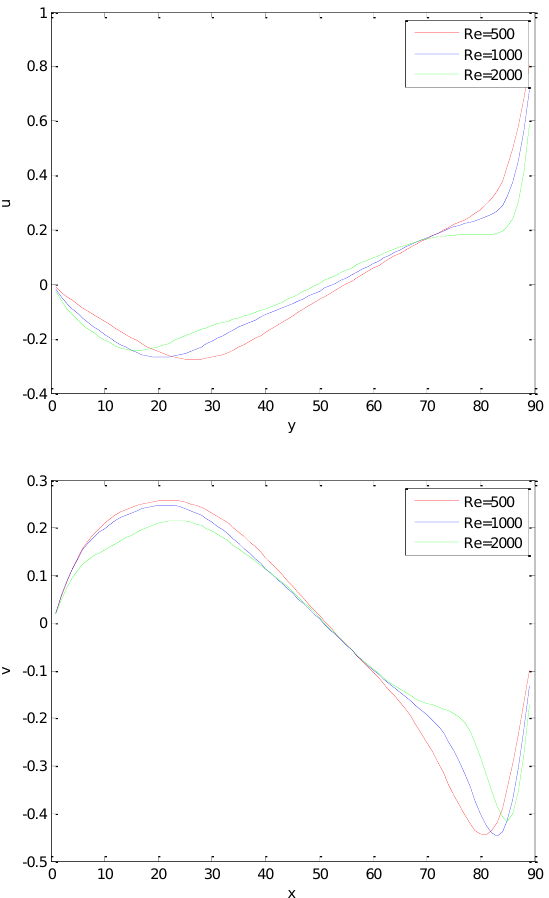
Figure 4. Variation of u- velocity and v- velocity at Re=500, Re=1000 and Re=2000